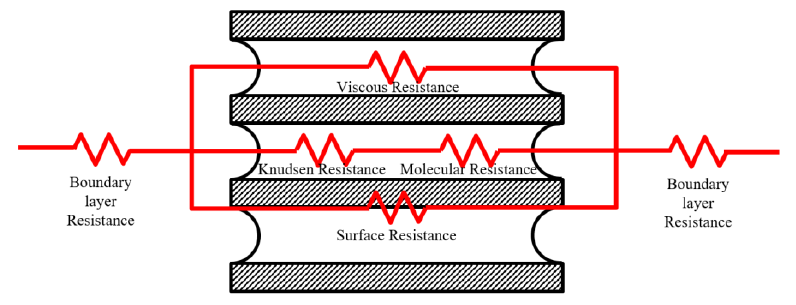
Figure 1. Serial and parallel arrangement of resistances to mass transport in MD